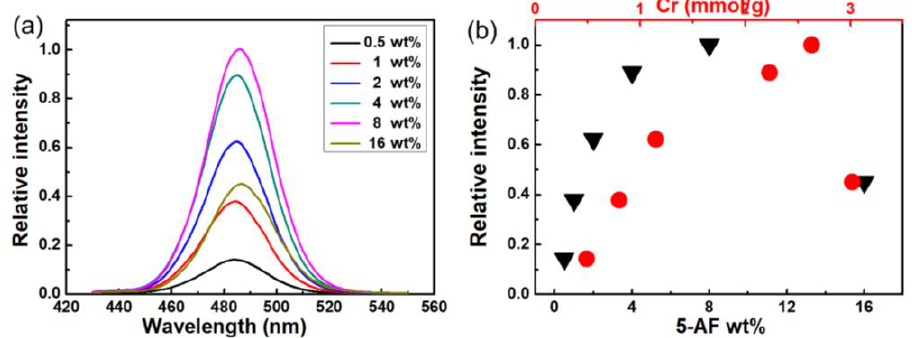
Figure 4. ( a ) The relative fluorescence intensity of HFNs in aqueous solution; ( b ) the relationship between PAA thickness, total carboxyl content (Ct) of HNs and the fluorescence intensity of HFNs. The synchronous fluorescence spectrum spectra were recorded at 25 °C.